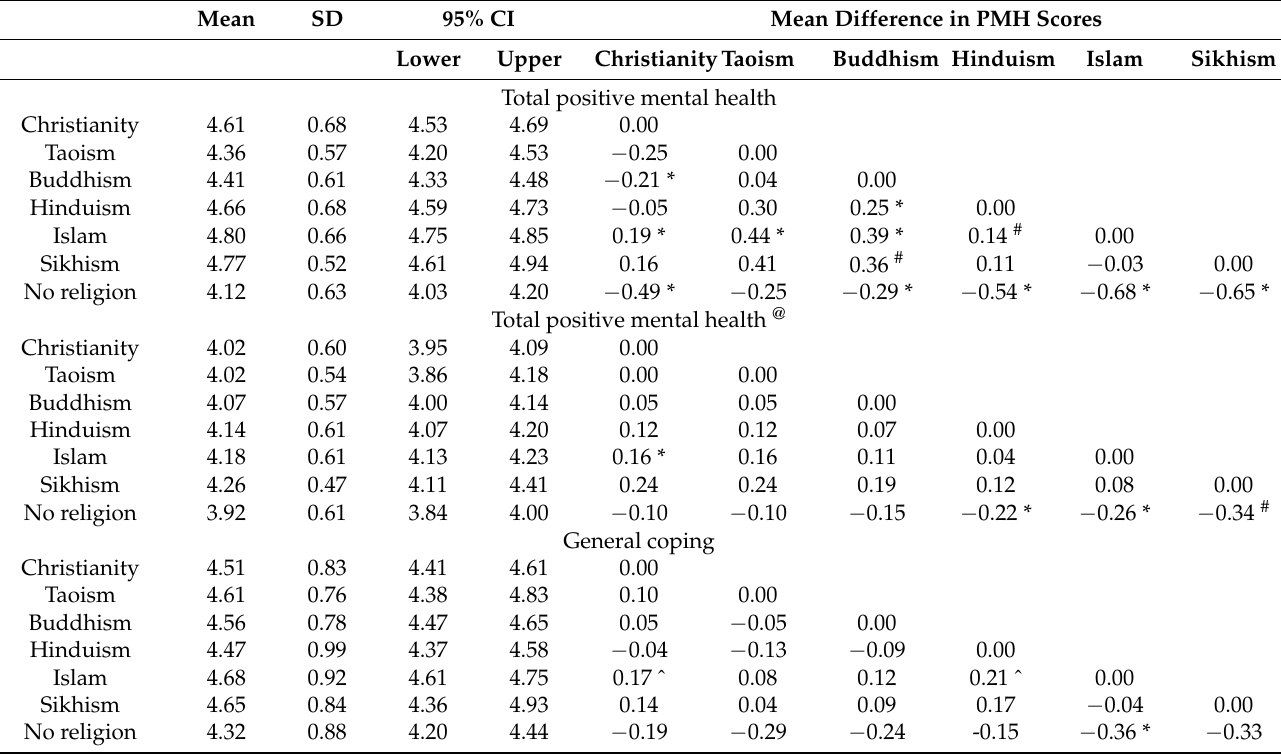
Table 3. Differences in total positive mental health and subcomponent scores across different religions